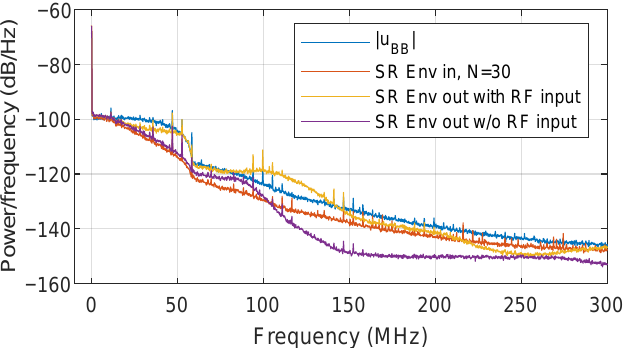
Figure 5. Power spectra density plot of the ETM output of an SR reduced envelope with and without RF